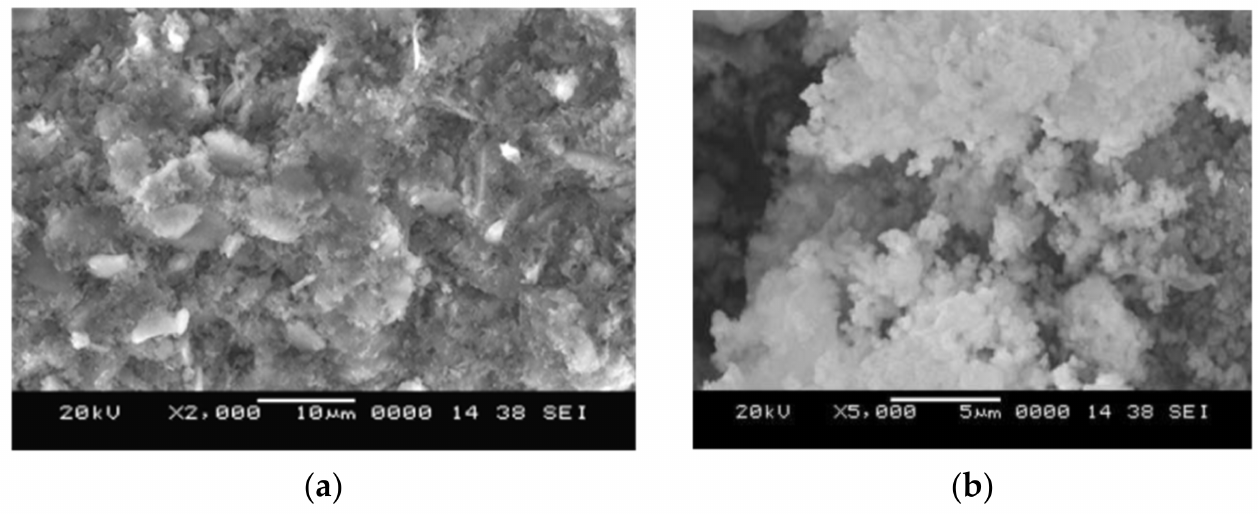
Figure 6. SEM analysis of geopolymer matrices with FA ( a ) and MK ( b ). Reproduced with permission from [48]. Copyright 2013